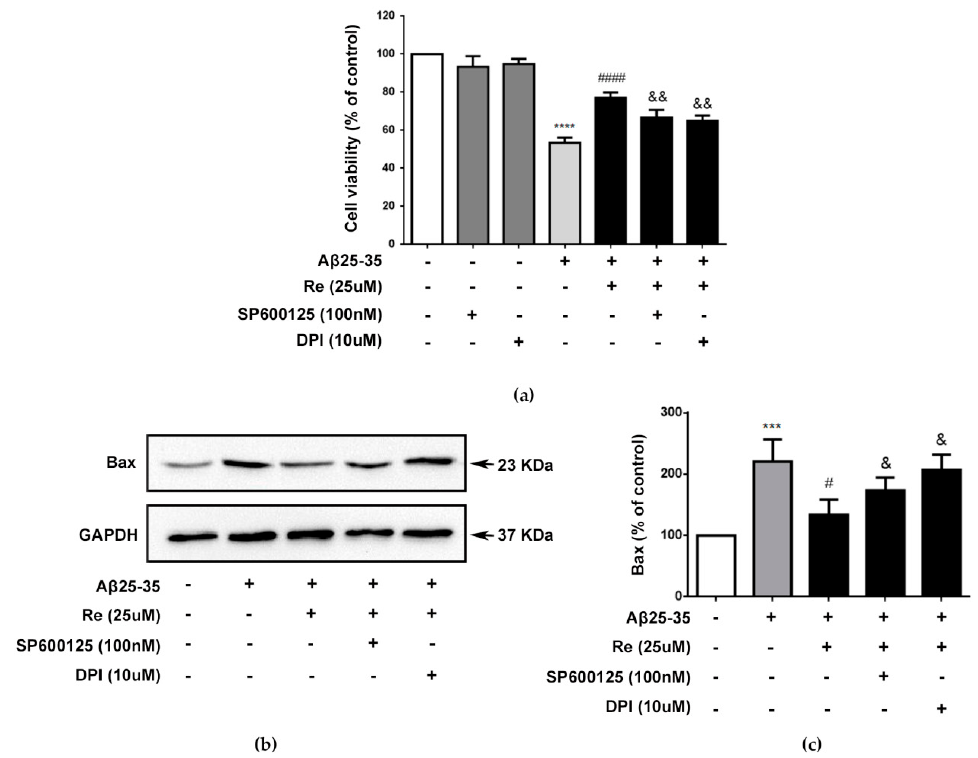
Figure 4. The neuroprotective effect of ginsenoside Re is dependent of ROS-dependent